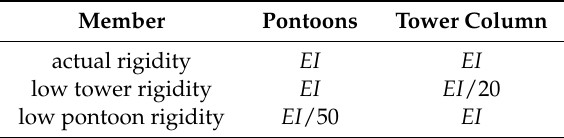
Table 10. Rigidity level applied for pontoons and tower column compared with the actual model.